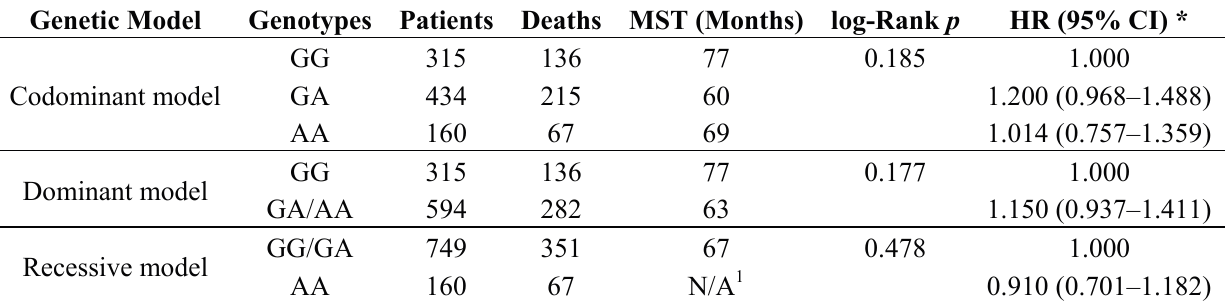
Table 2. Association between rs10505477 polymorphism and overall survival of gastric